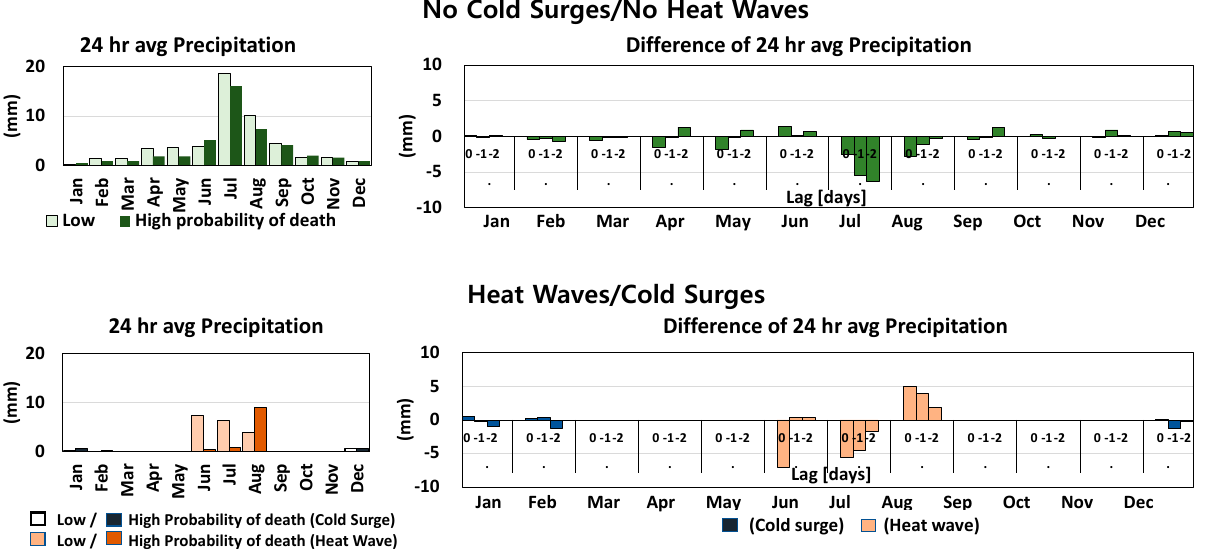
Figure 12. Comparison of monthly average temperatures on days of high and low probability of death and the differences in temperatures (temperature (high probability of death) –temperature (low probability of death) ) from zero to two days before death.